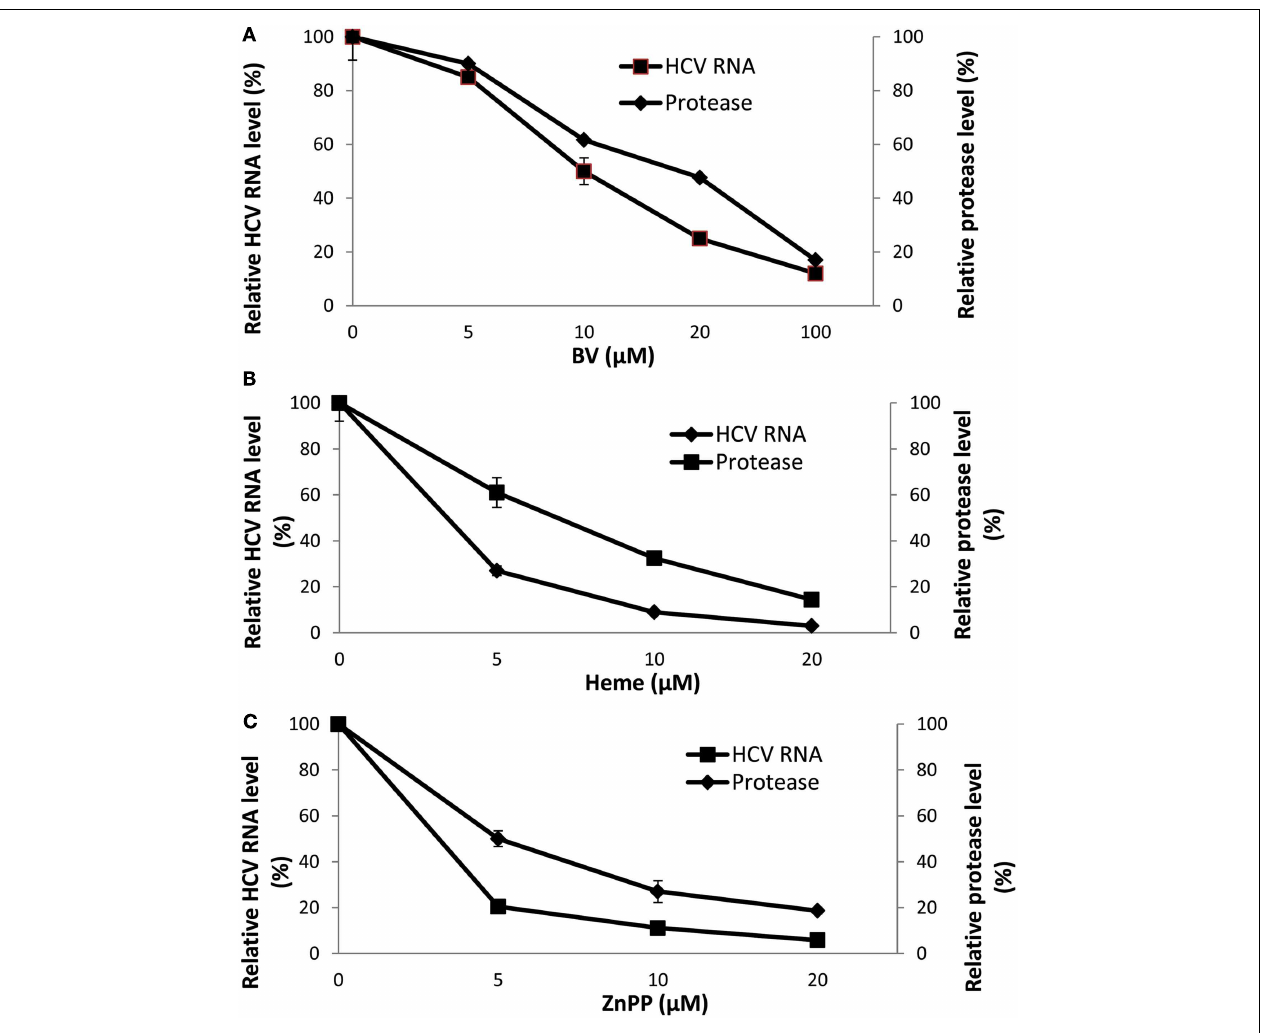
the inhibitory activity of each tetrapyrrole for recombinant HCV NS3/4A was determined by FRET analysis (Zhu et al., 2010a). Results are means ± SEM of six determinations per point. (With permission; Zhu et al.,